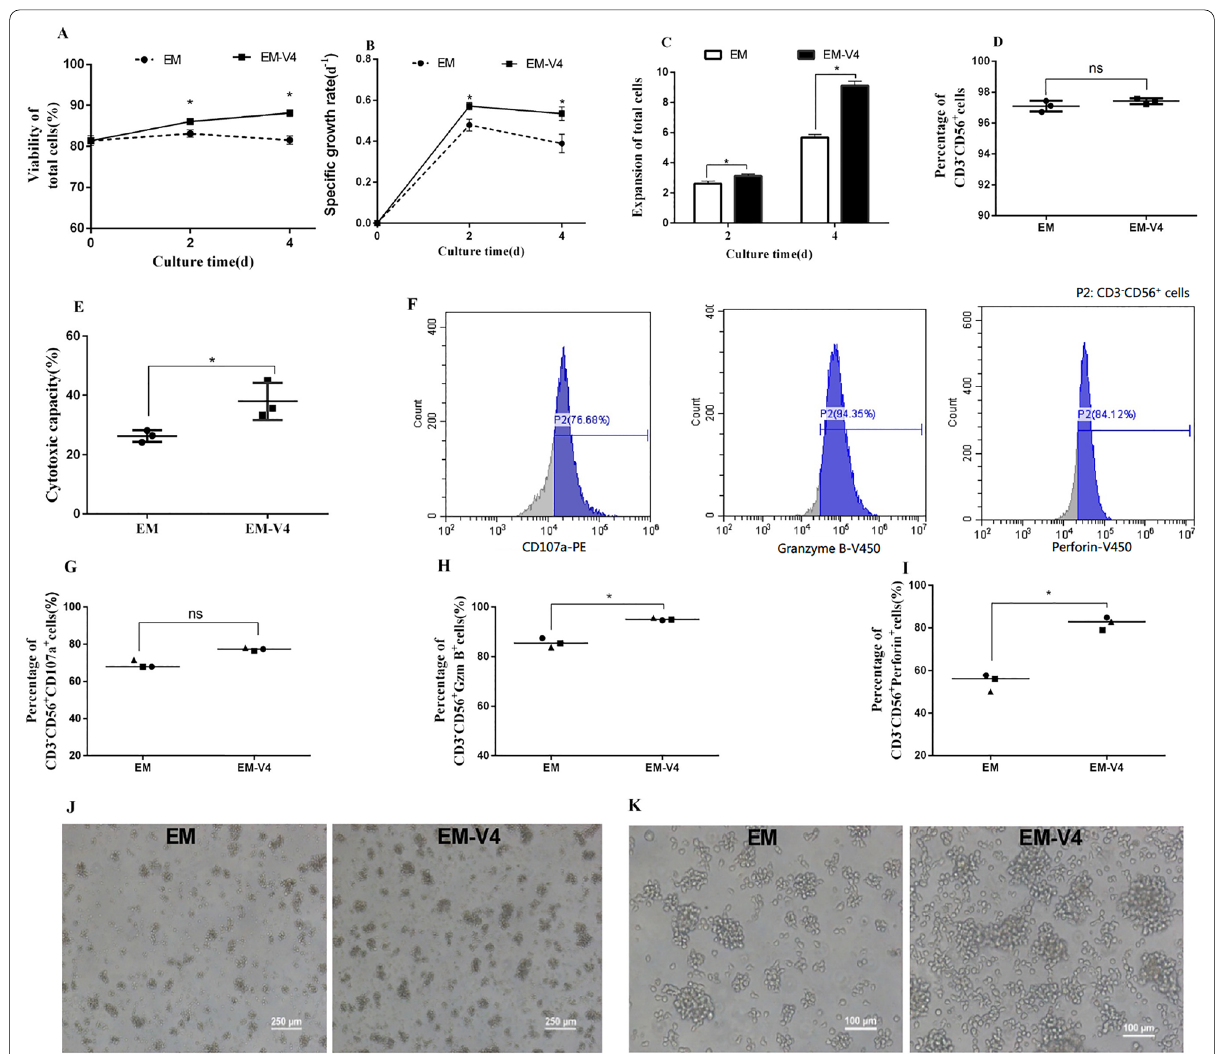
Fig. 2 Ex vivo expansion characteristics of NK‑92 cells. A Cell viability. B Specific growth rate of NK‑92 cells. C Expansion fold of the cells. D Percentage of CD3 − CD56 + cells. E Cytotoxicity of expanded NK‑92 cells on day 4 at an E:T ratio of 5:1. F Representative flow cytometric analysis of CD107a + , granzyme B + and perforin + cells which grew in EM‑V4; G Percentages of CD107a + cells gated on CD3 − CD56 + cells; H percentages of granzyme B + cells gated on CD3 − CD56 + cells; I percentages of perforin + cells gated on CD3 − CD56 + cells. J Light microscopic image of NK‑92 cell morphology at 40 times magnification on day 4. K Light microscopic image of NK‑92 cell morphology at 100 times magnification on day